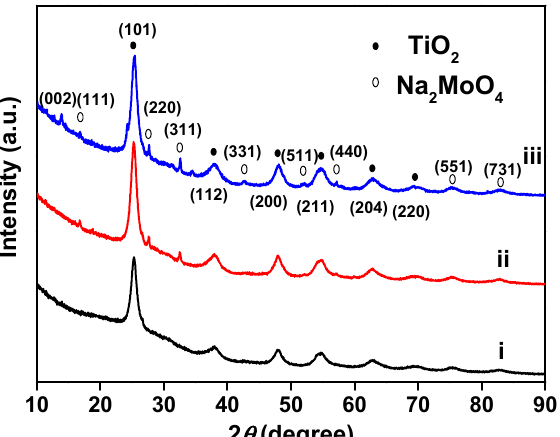
Figure 1. XRD patterns of the nanotubular Na 2 MoO 4 /TiO 2 composites of (i) Na 2 MoO 4 –15.4%-TiO 2 , (ii) Na 2 MoO 4 –24.1%-TiO 2 , (iii) Na 2 MoO 4 –41.4%-TiO 2 . Figure 2a exhibits the FT-IR spectra of the pure Na 2 MoO 4 powder and the nanotubular Na 2 MoO 4 /TiO 2 composites. The bands located at 838–802 cm − 1 in the spectrum of the pure Na 2 MoO 4 powder are attributed to the stretching modes of the α -Na 2 MoO 4 phase [51,52]. For those FT-IR spectra of the Na 2 MoO 4 –41.4%-TiO 2 and Na 2 MoO 4 –24.1%-TiO 2 samples, there are vibrational frequencies observed at 856–831 cm − 1 and 856–834 cm − 1 , which are also assigned to the stretching modes of the α -Na 2 MoO 4 phase. The slight blue shift of the Na 2 MoO 4 /TiO 2 composites is due to the interfacial effect of the tensile vibration between the Na 2 MoO 4 and TiO 2 phases. However, for the FT-IR spectrum of the Na 2 MoO 4 – 15.4%-TiO 2 sample, there are no obvious peaks that attributed to the α -Na 2 MoO 4 phase due to the rather low content of the Na 2 MoO 4 component in this composite. For the Na 2 MoO 4 –15.4%-TiO 2 , Na 2 MoO 4 –24.1%-TiO 2 , and Na 2 MoO 4 –41.4%-TiO 2 samples, the bands centered at 600, 580, and 460 cm − 1 are correspondingly assigned to the stretching vibration of Ti − O − Ti in TiO 2 [53–57]. In addition, the adsorption bands around 3400 and 1640 cm − 1 for all spectra are indexed to the H − O − H stretching vibration in the molecularly adsorbed H 2 O [53–56]. The Raman spectra of the nanotubular Na 2 MoO 4 /TiO 2 composites and the pure Na 2 MoO 4 powder are revealed in Figure 2b. The bands located at 148, 397, 516, and 636 cm − 1 in the spectra of the Na 2 MoO 4 /TiO 2 composites are attributed to the E g , B 1g , A 1g , and E g modes of the anatase phase TiO 2 [58]. The obvious peak at 895 cm − 1 in the spectrum of the pure Na 2 MoO 4 powder is ascribed to the symmetric stretching modes of MoO 42 − [59]. Correspondingly, for the spectra of the Na 2 MoO 4 –15.4%-TiO 2 , Na 2 MoO 4 –24.1%-TiO 2 and Na 2 MoO 4 –41.4%-TiO 2 samples, the stretching vibration peaks at 892, 929, and 950 cm − 1 all belong to the symmetric stretching modes of MoO 4 2 − , which display slight shifts as compared with that of the pure Na 2 MoO 4 powder, demonstrating the strong interaction between MoO 42 − and TiO 2 .